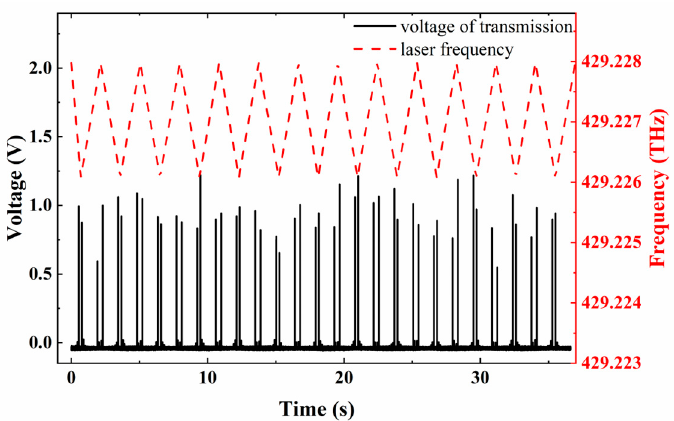
Figure 5. Voltage of PD3 during laser frequency tuning. Table 2. Statical experimental data for voltage of PD3, before and after vibration tests.